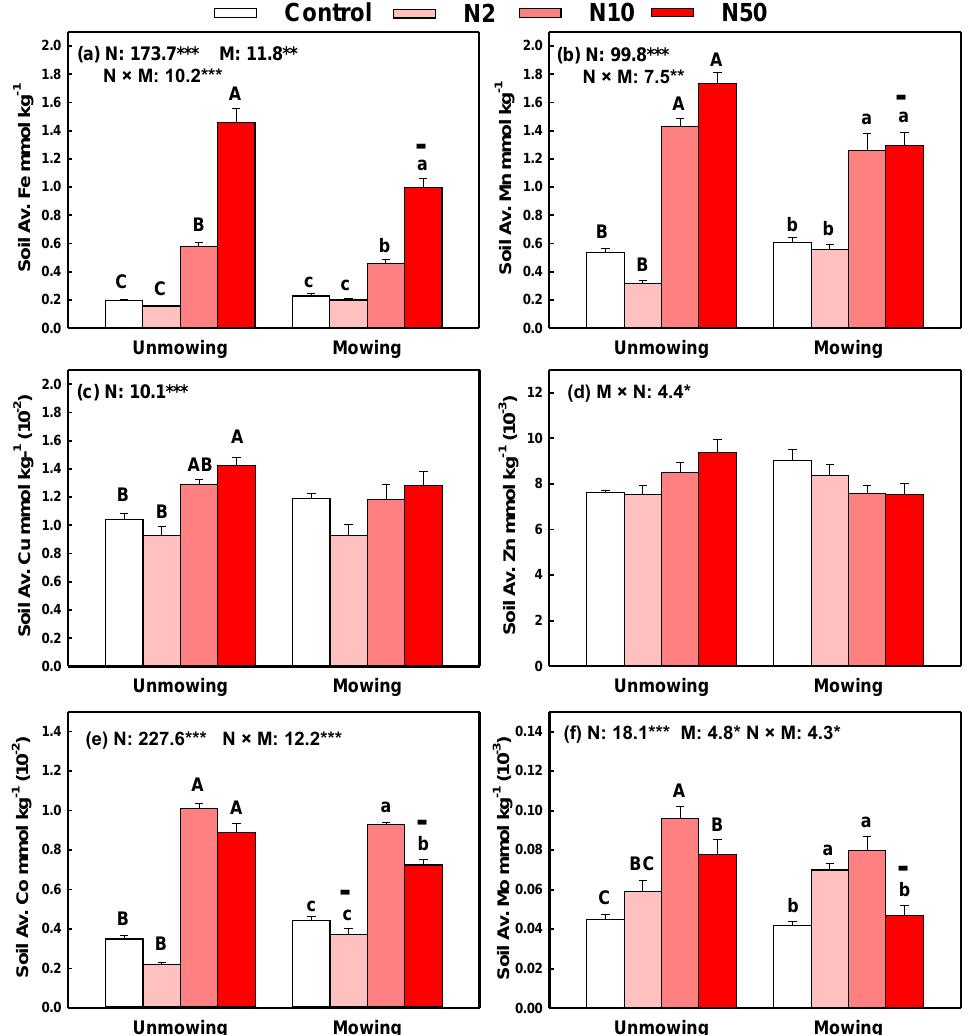
Figure 1. Effects of N addition on the contents of soil-available Fe, Av. Fe; available Mn, Av. Mn; available Cu, Av. Cu; available Zn, Av. Zn; available Co, Av. Co and available Mo, Av. Mo with unmowing and mowing treatments. Note: Data are presented as means ± standard error. The results of two-way ANOVA (F values) are shown at the top of each figure. *, **, *** indicates significant differences at p < 0.05, 0.01, 0.001, respectively. Different uppercase or lowercase letters denote significant differences ( p < 0.05) between control and N addition plots with unmowing and mowing treatments. Symbols +, − indicate significant positive or negative effects of mowing compared with their counterparts with the same N addition rate at p < 0.05. Only items with significant cases were shown.